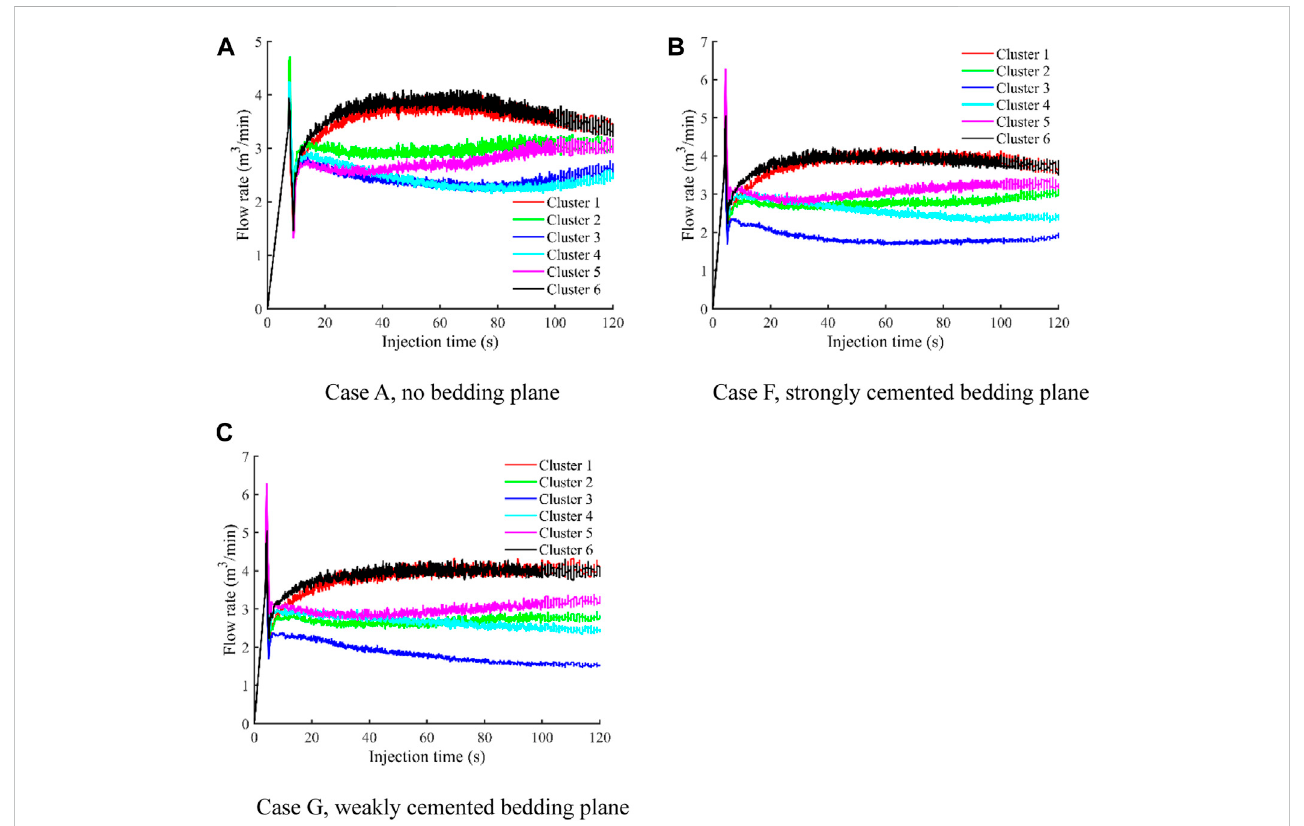
FIGURE 7 Flow rate into each cluster as a function of time for three cases with different bedding development levels. (A) Case A, no bedding plane. (B) Case F, strongly cemented bedding plane. (C) Case G, weakly cemented bedding plane.